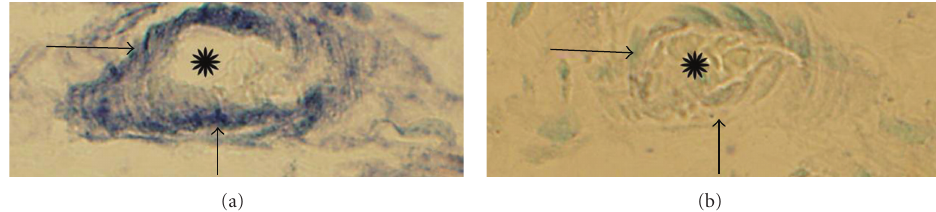
Figure 9: In situ hybridization for the demonstration of TNF-alpha mRNA in a small blood vessel: antisense staining (a), and sense staining (b). The vessel was located in the proximity of an inflammatory infiltrate. Arrows point at the wall. There are reactions in the wall in (a) but not in (b). Asterisks are in the lumen.